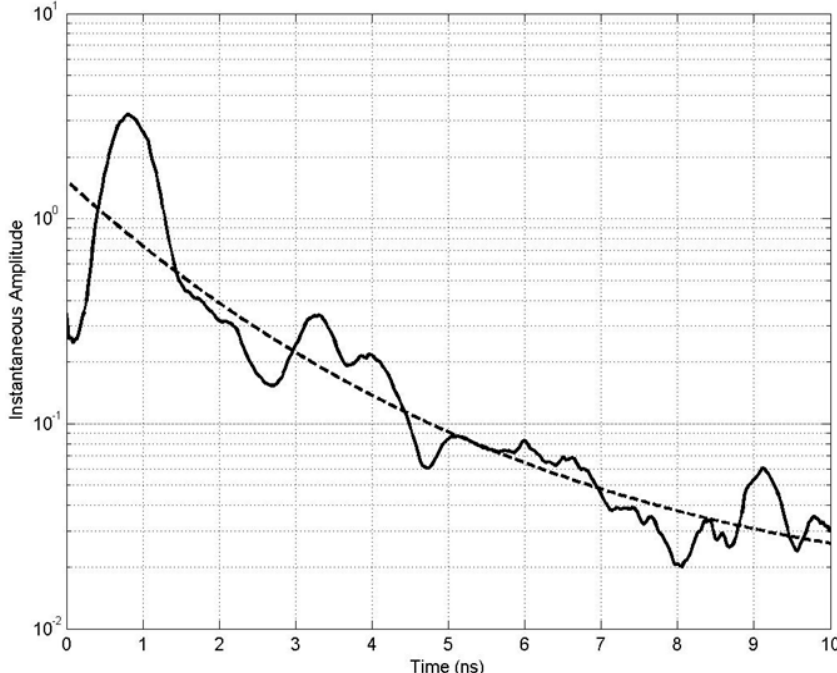
Figure 7. The average instantaneous amplitude (or envelope) of all the GPR traces depicted in Figure 6 (continuous line) and an exponential function fitted through it (dashed line).